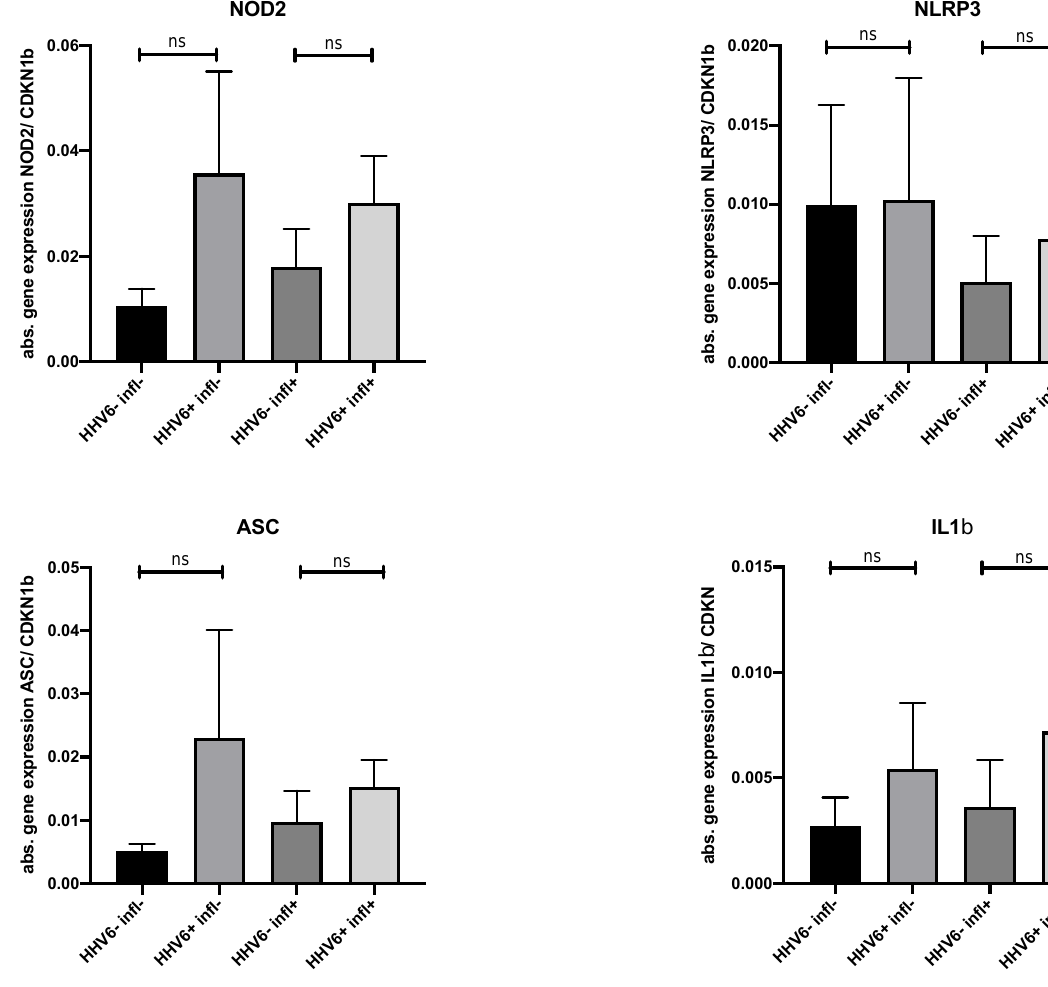
Figure 4. HHV6 DNA presence in the myocardium has no significant effect on the mRNA expres- sion of NOD-like receptor pyrin domain-containing-3 inflammasome components both in presence and absence of myocardial inflammation. Bars represent the absolute gene expression values as mean ± SEM. Cyclin Dependent Kinase Inhibitor 1B (CDKN1b) was used as endogenous control. NOD2, nucleotide-binding oligomerization domain-containing protein 2; ASC, adaptor protein ASC; IL1 β , interleukin 1-beta. N = 4 – 6 patients/group. ns p ≥ 0.05.